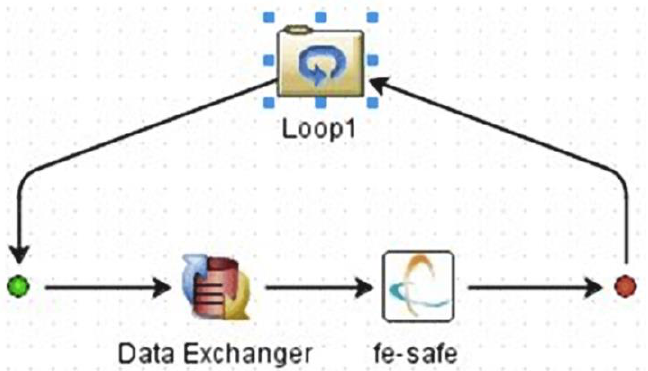
Figure 14. Isight computational loop.